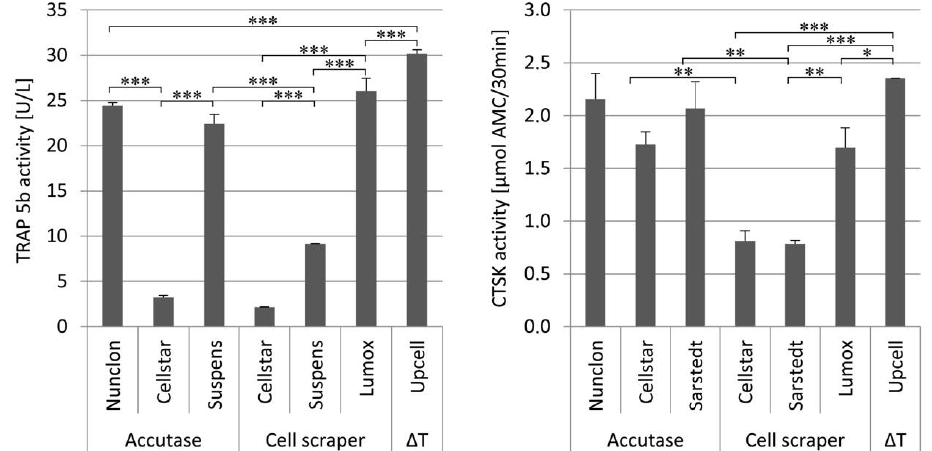
Figure 5. Intracellular TRAP 5b activity ( left ) and intracellular CTSK activity ( right ) of reseeded mature osteoclasts de- pending on the different detachment methods after 7 days of cultivation on Nunclon TM reference plates, * indicate p < 0.05, ** indicate p < 0.01.